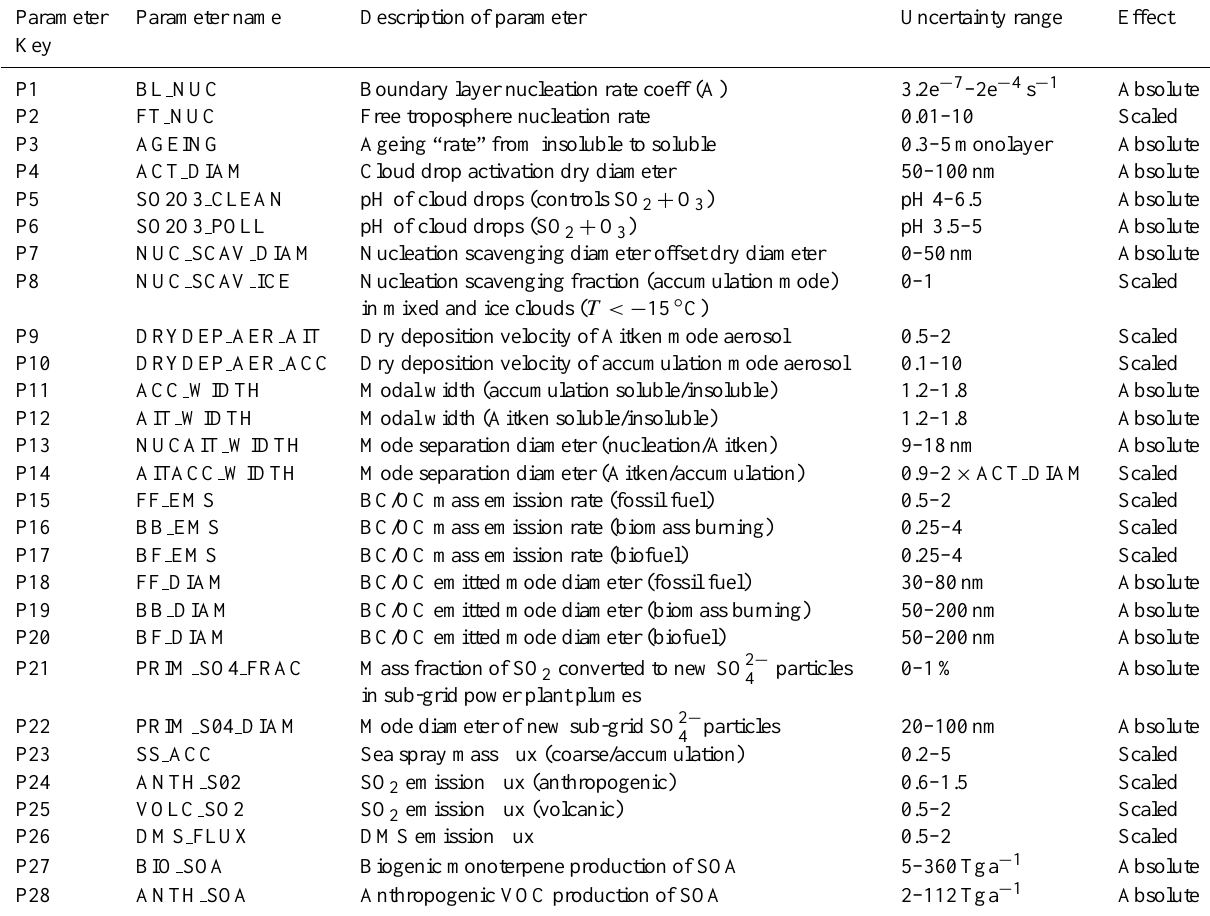
Table 1. The uncertain parameters and emissions